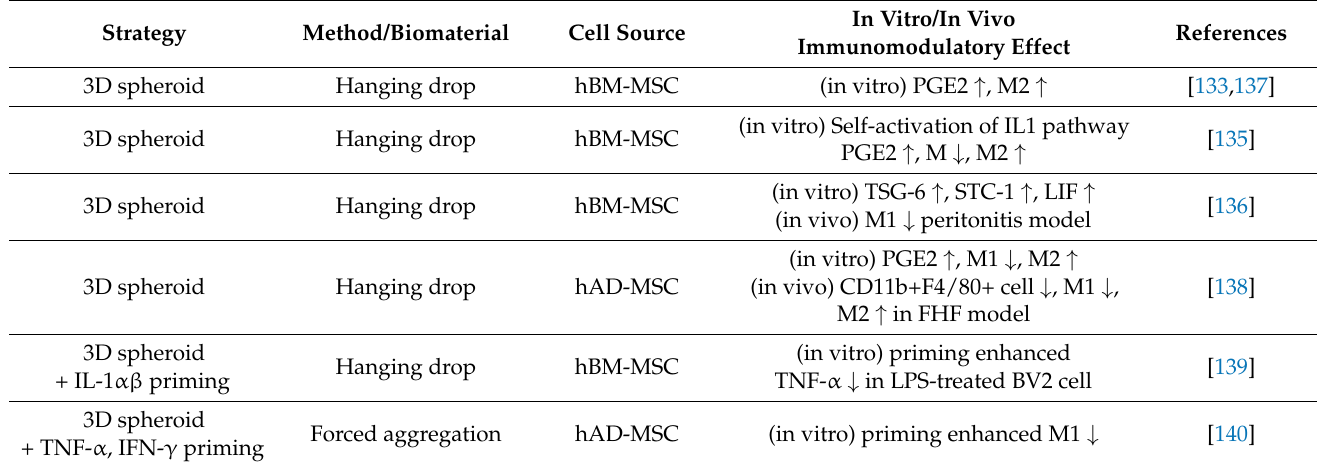
Table 3. Influence of 3D assembly on MSC-mediated immunoregulatory